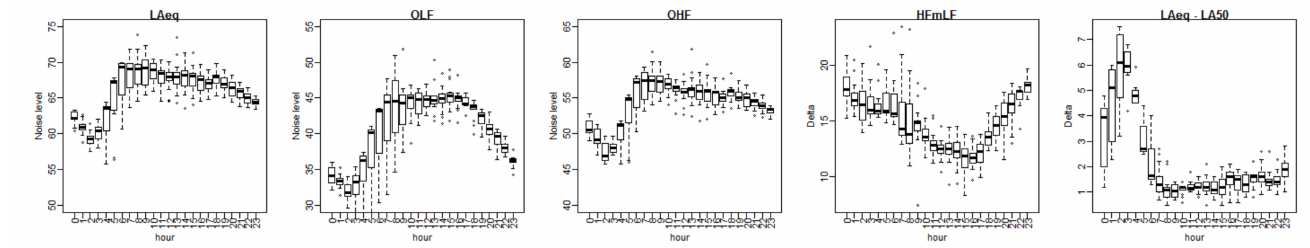
Figure 3. Diurnal patterns of the noise parameters: L Aeq , OLF, OHF, HFmLF and the difference between L Aeq and L A50